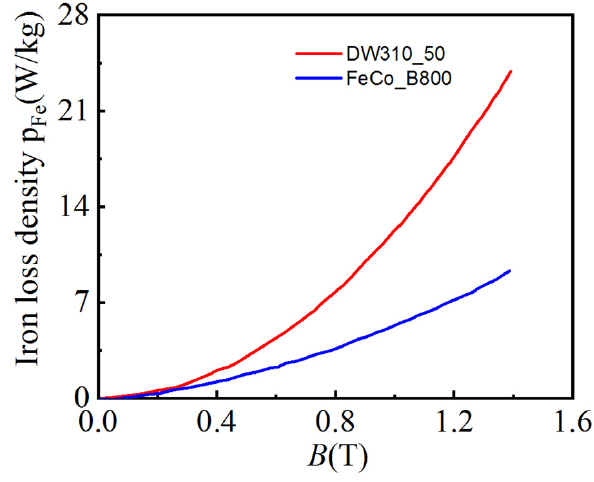
Figure 5. Comparison of iron loss density curves.